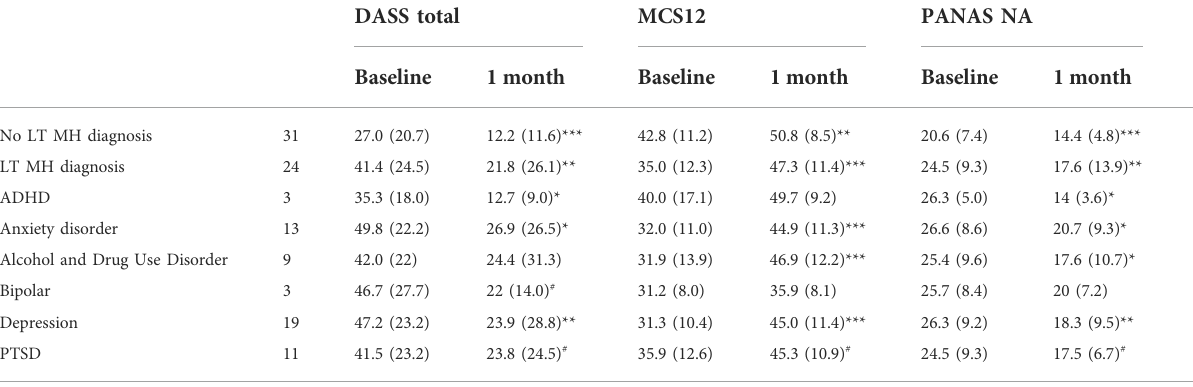
TABLE 3 Relationships between lifetime (LT) diagnostic group and mental health improvements from repeated measures at baseline and 1 month a